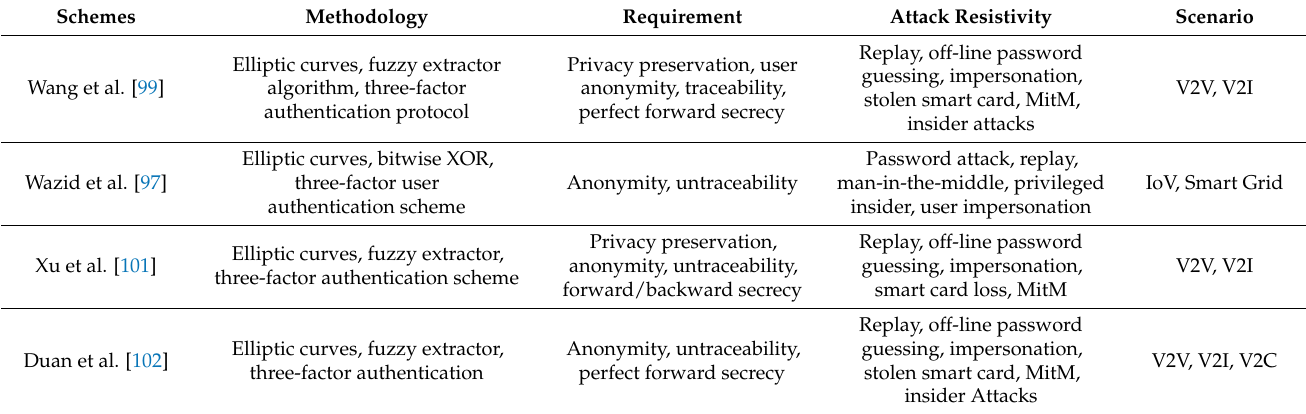
Table 9. Classification of smart card (three-factor) authentication schemes.